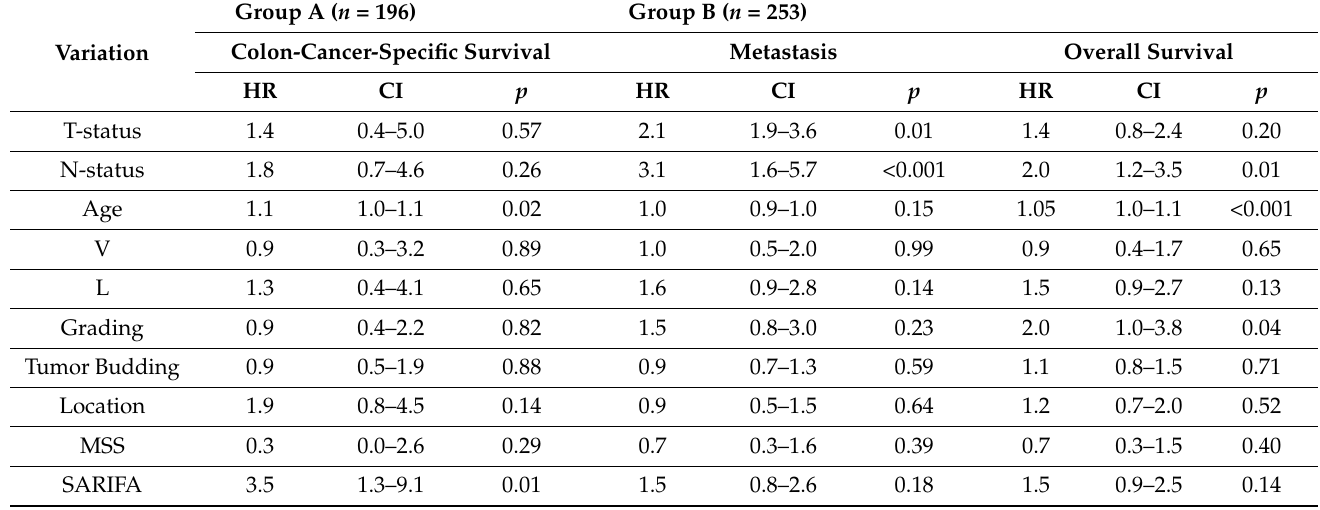
Table 3. Cox regression